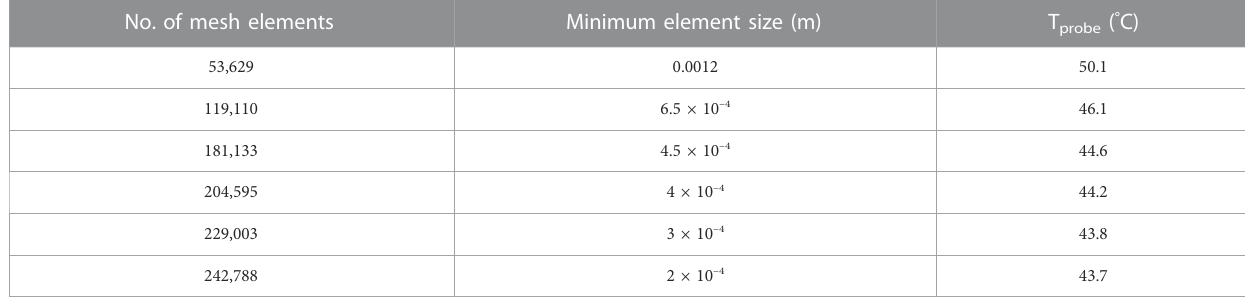
TABLE 3 Mesh sensitivity analysis performed on agarose gel + Cu wire system. Data sourced from Sharma et al. (2023). No. of mesh elements